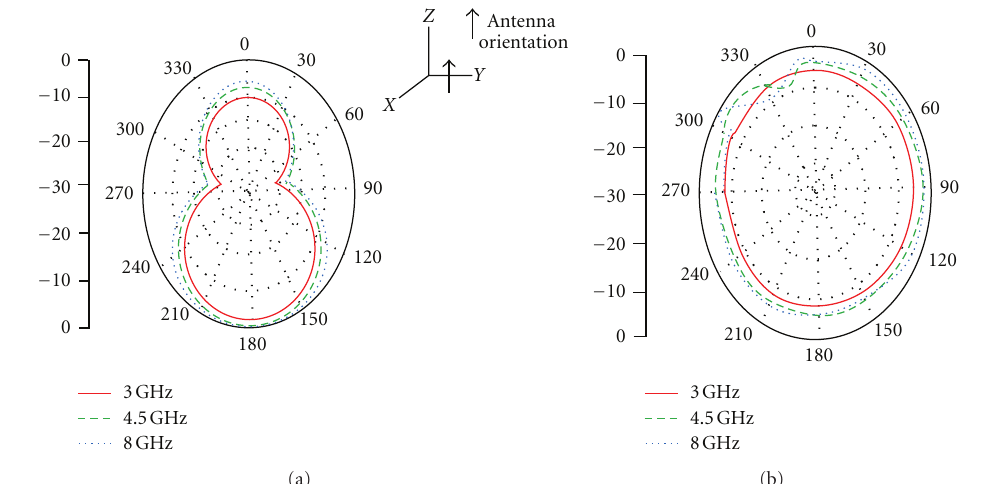
Figure 8: (a) Radiation pattern of the proposed antenna—E Plane ( y - z ). (b) Radiation pattern of the proposed antenna—H Plane ( x - y